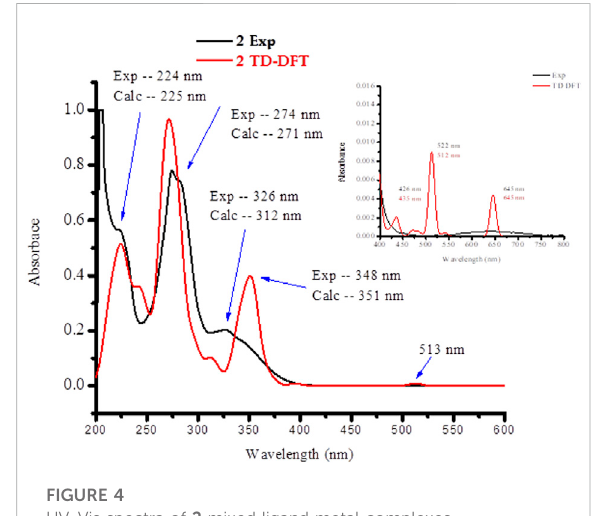
FIGURE 3 UV-Vis spectra of the synthesized mixed ligand metal complex 1 .